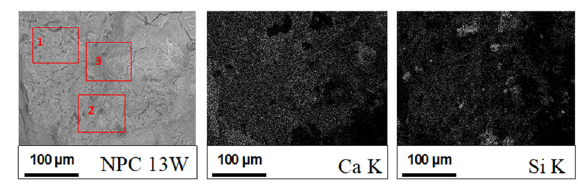
Figure 16. SEM picture of NPC specimens and EDX maps for Ca and Si at ×500 magnification.